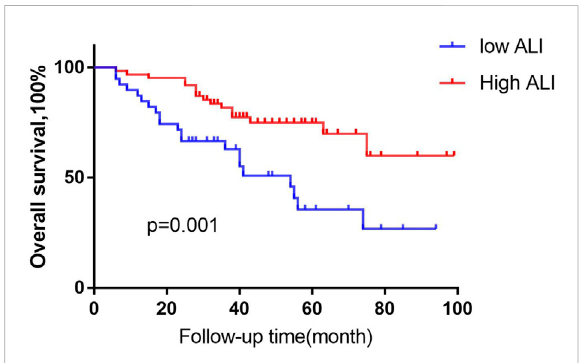
FIGURE 1 Kaplan-Meier analysis of OS based on ALI status. Using the X-tile program, an optimal cut-off value for ALI of 32.7 was determined. We de fi ned MM patients the high- ALI group, ( n = 66 cases) and the low -ALI group, ( n = 45). Low-ALI patients with MM were signi fi cantly correlated with poor prognosis compared with high-ALI patients with respect to overall survival (OS; p = 0.001, log-rank